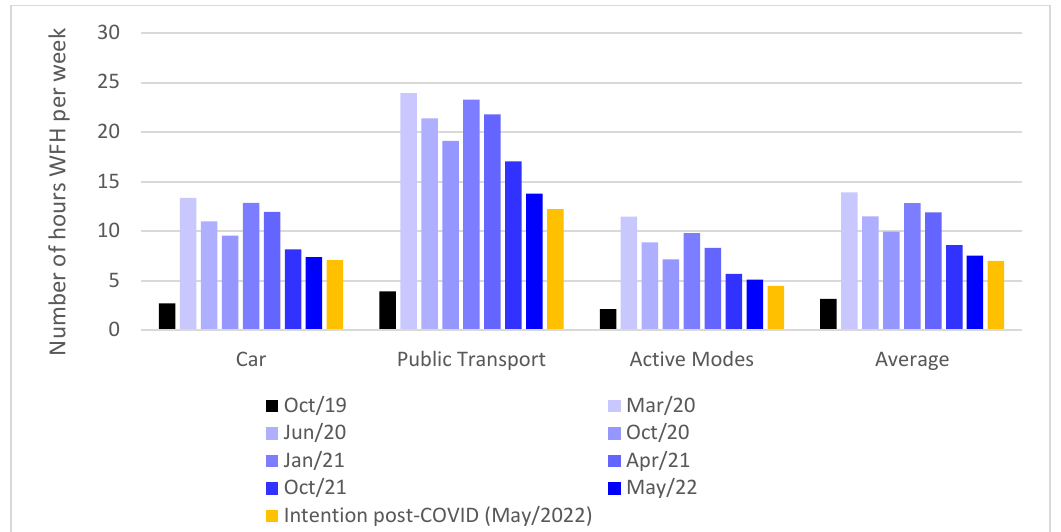
Figure 5. Average number of hours worked from home per week, grouped by the main commute mode used before the pandemic (Data: MPN questionnaire, all measurements since October 2019, N =